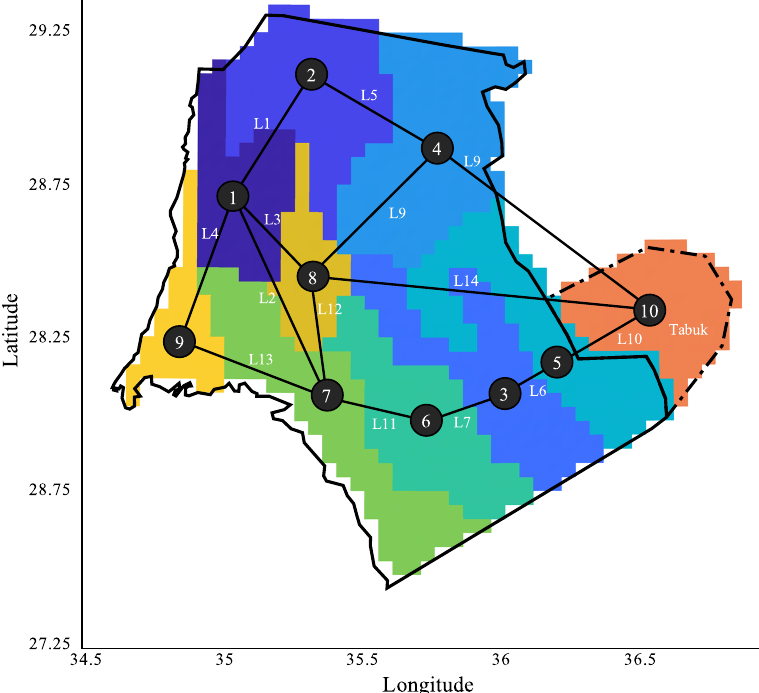
Fig. 1 Nodal system for Neom. Generation technologies can be built on ten nodes and linked via 14 possible transmission lines